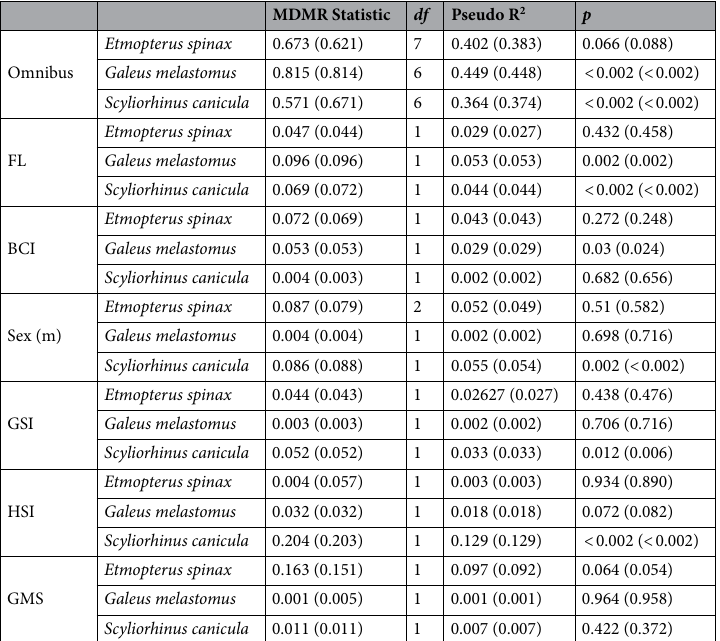
Table 4. Results of MDMR analyses relating the pairwise compositional similarity of each shark species based on the abundance (square root transformed) of parasites with morphological (FL, weight, and BCI) and physiological (Sex, GSI, HSI, and GMS) variables. Omnibus refers to the cumulative effect of all predictors on the distance matrix. Values in parentheses refer to the results obtained by including extremely rare parasite species (i.e., those parasites present with a single individual in a single